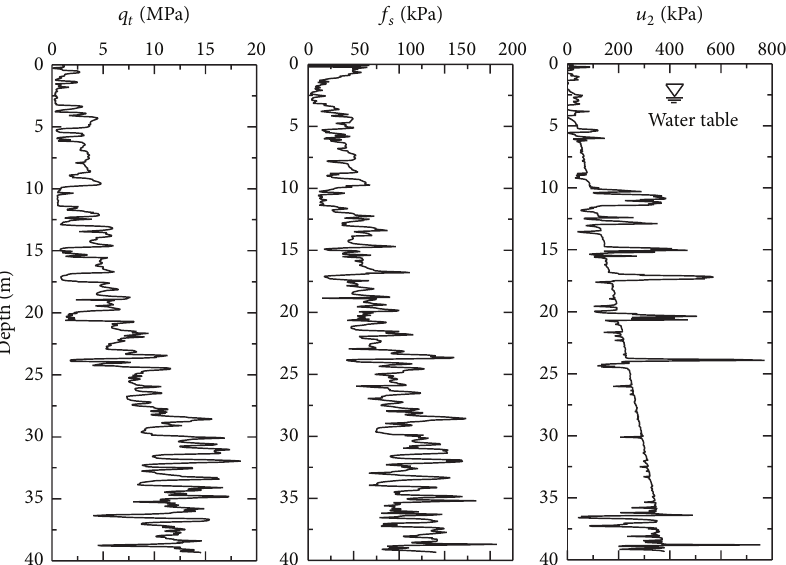
Figure 5: Results of